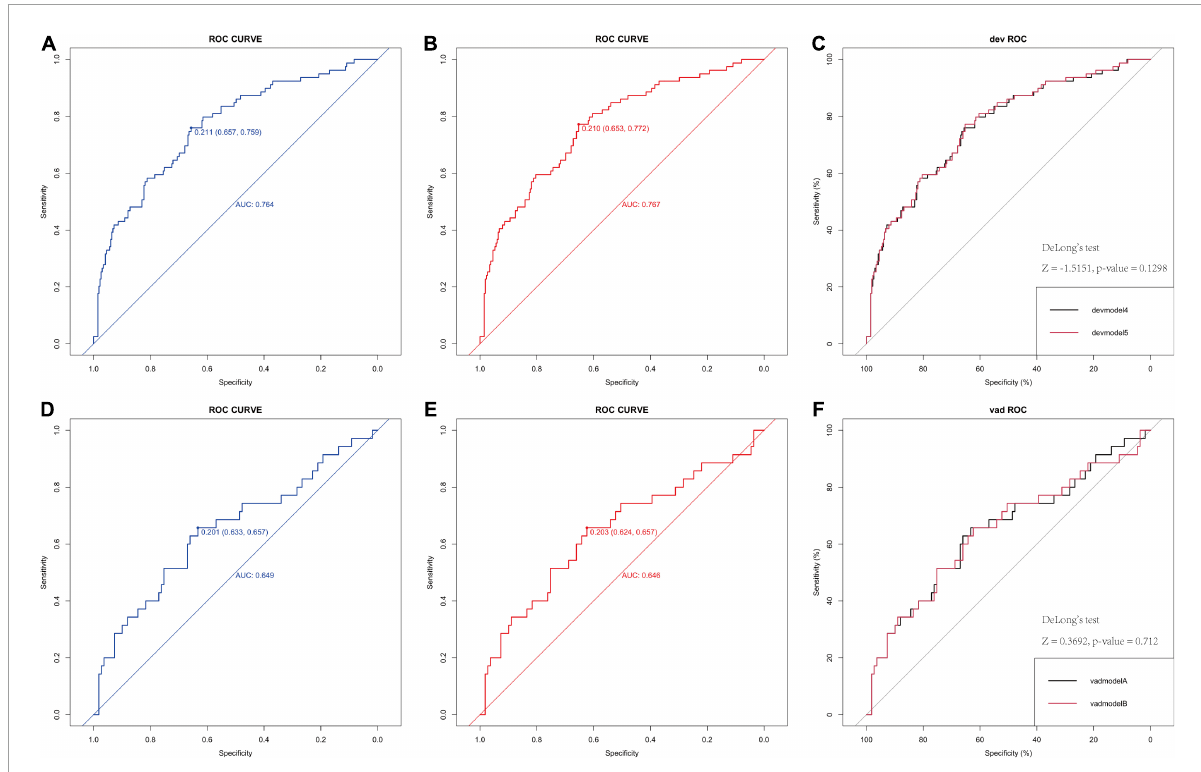
FIGURE1 Receiver operating characteristic (ROC) of the logistic model in predicting poor neurological outcome in derivation and validation cohorts. (A,B) ROC curve of 6-factor and 5-factor logistic model for the developing in-house data which show the AUC value. (C) The comparison between the two models by the Delong’s test. (D,E) ROC curve of 6-factor and 5-factor logistic mode for the validating in-house data which show the AUC value, indicating both models have good predict ability. (F) The comparison between the two models by the Delong’s test. AUC, area under the receiver operating characteristic